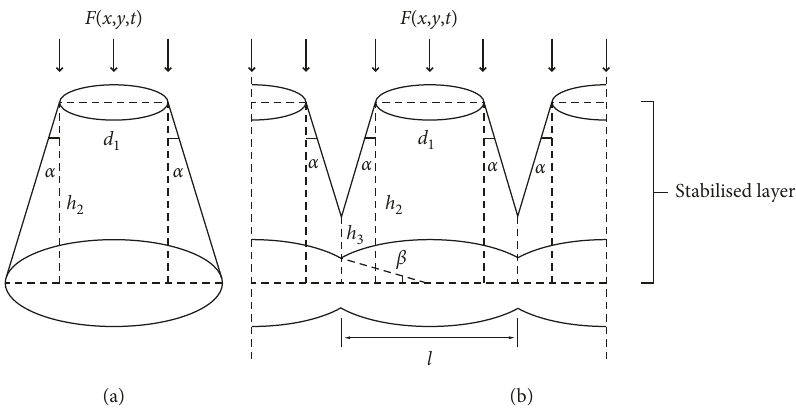
Figure 2: Load diffusion model: (a) single jack and (b) three